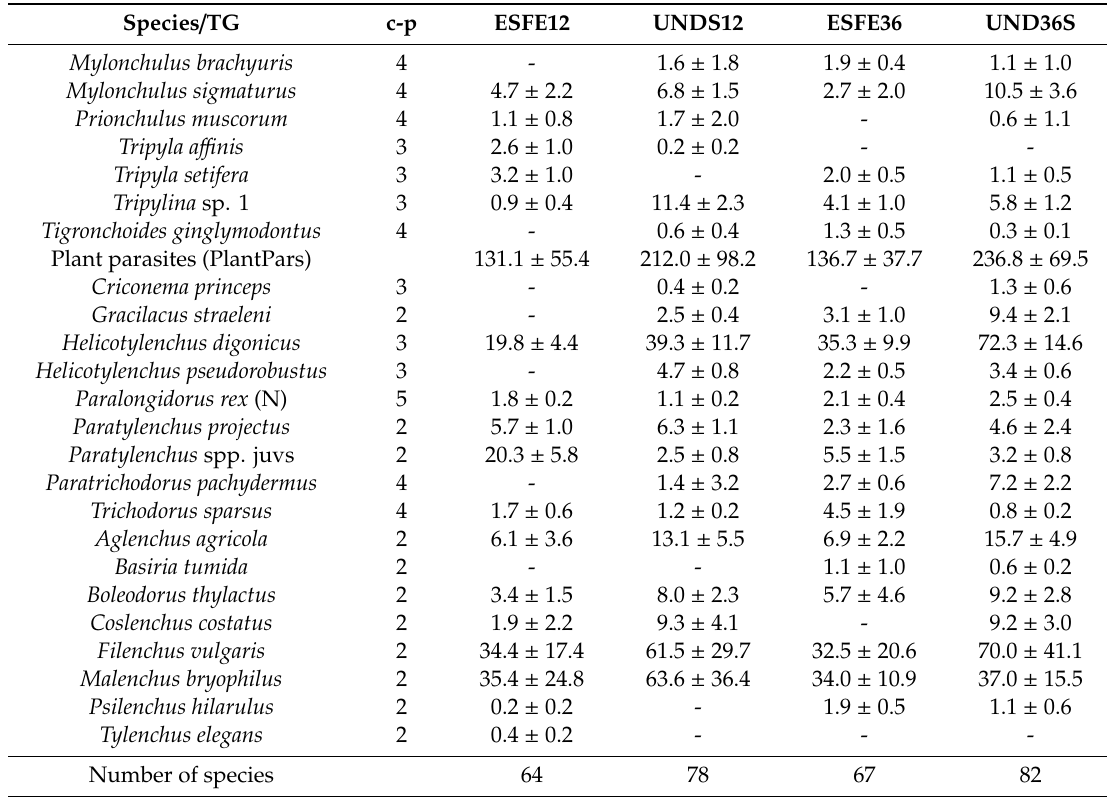
(N)—species new for Slovak nematode fauna. Table 4. Total nematode abundance, number of species, nematode functional guilds abundance associated with early-successional forest ecosystem (ESFE) and windstorm undisturbed areas (UNDS), 12 and 36 months after event. Each data is an average of the individual plots and sampling date (mean ±